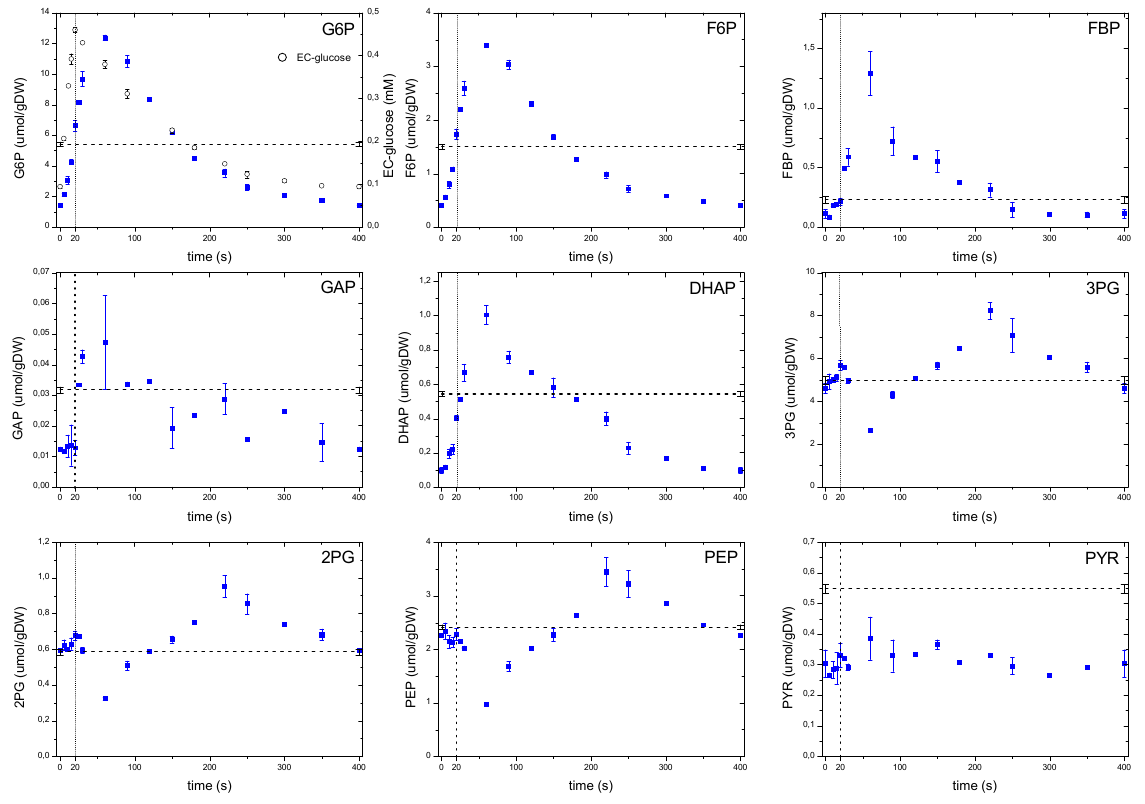
Figure 5. Concentration measurements of glycolytic metabolites during the feast/famine cycle. The dashed line represents the reference steady-state (D = 0.1 h − 1 ), error bars represent the standard error of duplicate determination during two subsequent cycles. The vertical dotted line represents the end of the feeding